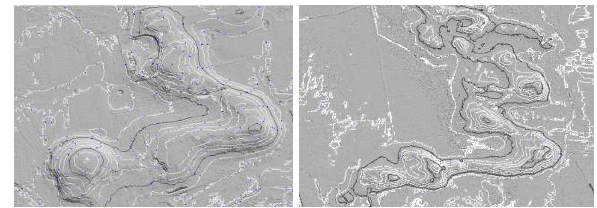
Figure 13. Contours and DTM – suspected structures – objects 3 and 4